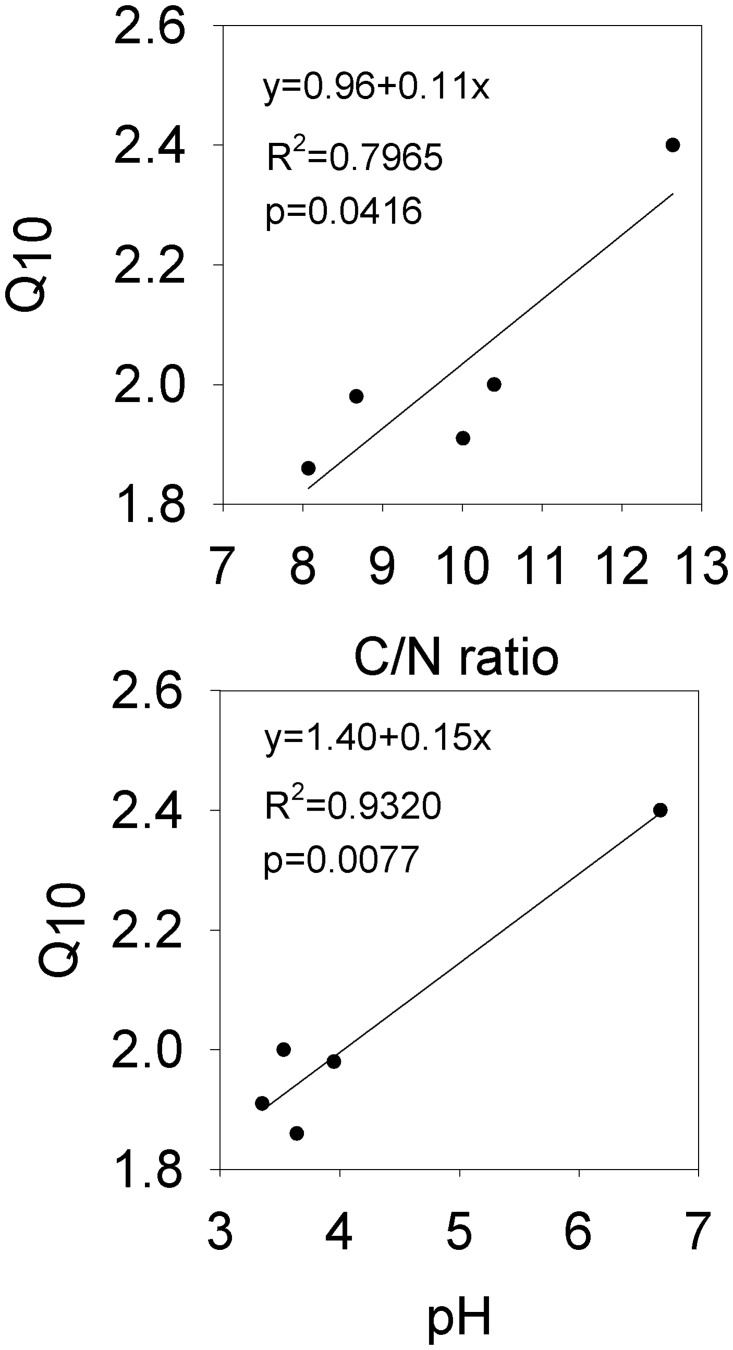
Correlation of Q10 with the C/N ratio and pH.